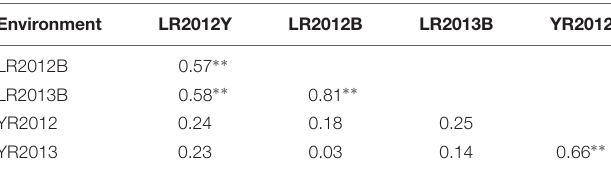
TABLE 1 | Pearson’s correlation coefficients ( r ) among the UC1110/PI610750 RILs for final leaf rust severities in three environments (Ciudad Obregón LR2012Y, El Batán LR2012B and LR2013B) and stripe rust severities in two (Toluca YR2012 and YR2013) environments in Mexico.